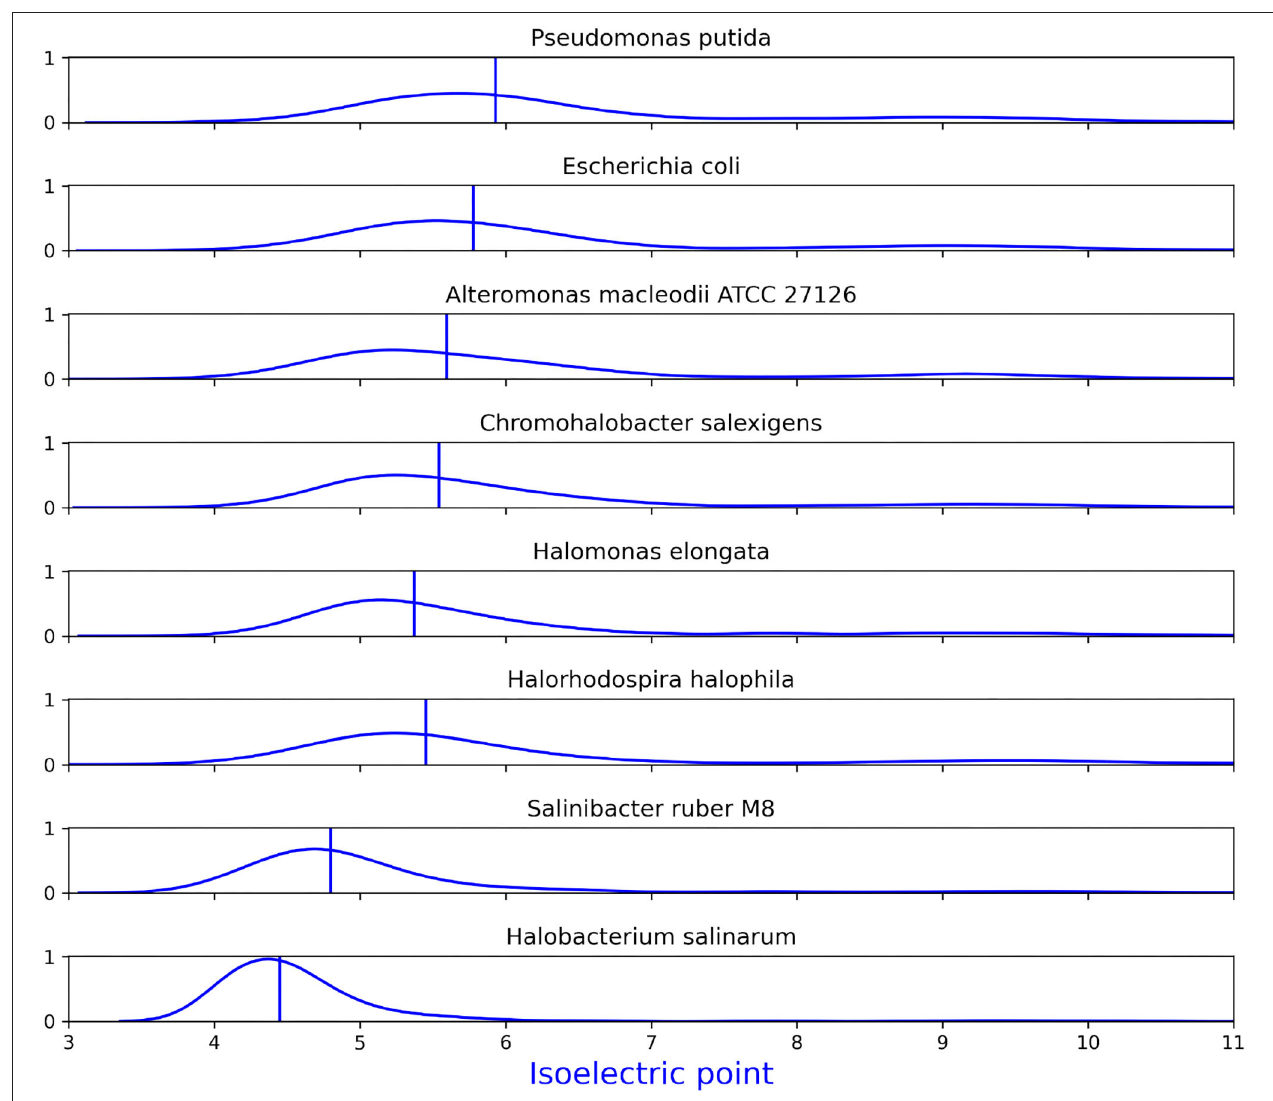
FIGURE 10 | Distribution of isoelectric points in the cytosolic proteins of several prokaryotes as density plots. Vertical lines show the median for each plot. The amount of genes to which psort could assign a reliable location varies from one bacteria to another as does the fraction of this that were classified as cytosolic. The amount of proteins identified as cytosolic was: Pseudomonas putida : 2457, Escherichia coli : 1935, Alteromonas macleodii ATCC 27126: 1616, Chromohalobacter salexigens : 1726, Halomonas elongata : 1958, Halorhodospira halophila : 1301, Salinibacter ruber M8: 1358, Halobacterium salinarum: 1250